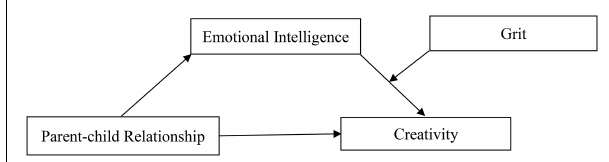
FIGURE 1 | The mechanism effect of vocational college students’ parent-child relationship on